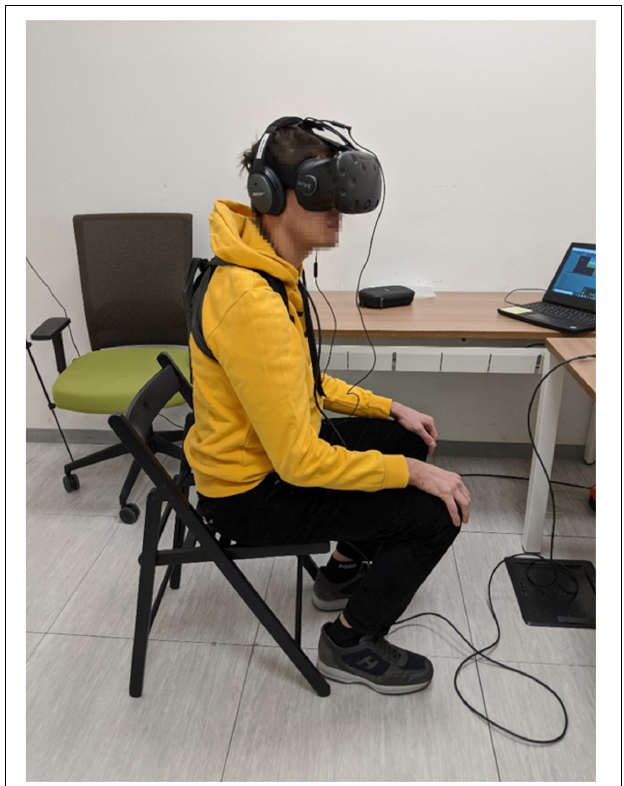
FIGURE 1 | Hardware and room setting during an experimental session. The participant wears the VR headset, the headphones and a custom-made harness to keep the smartphone on his/her back. During each trial, the participant sits and his/her back is free to